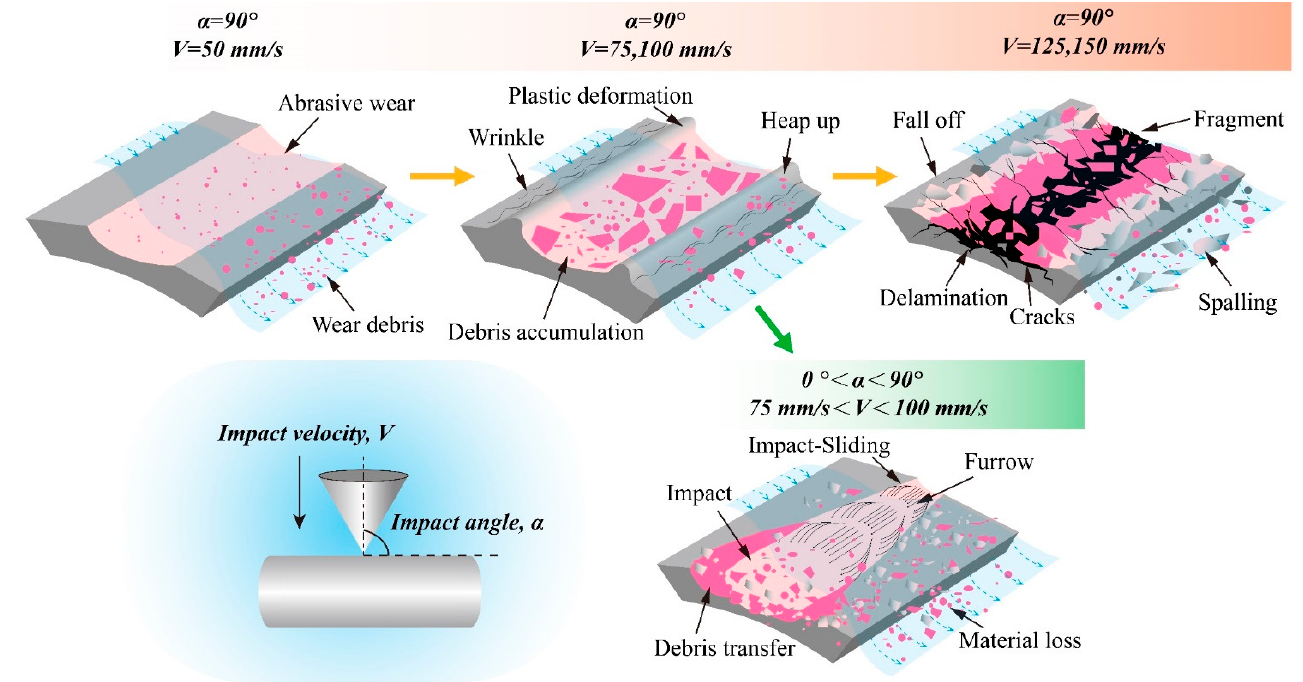
Figure 15. Schematic of the wear mechanisms.